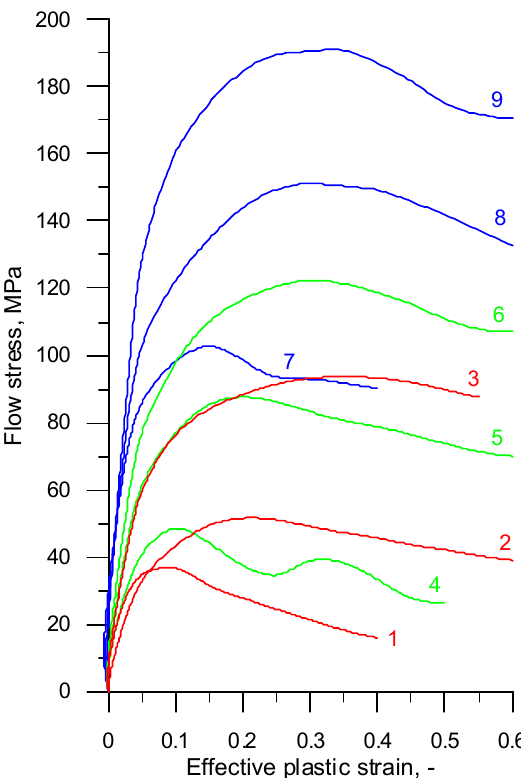
Figure 2. Experimental flow curves for 100Cr6 steel, where 1— T = 1200 °C, ε(cid:4662) = 0.1 s − 1 ; 2— T = 1200 °C, ε(cid:4662) = 1 s − 1 ; 3— T = 1200 °C, ε(cid:4662) = 10 s − 1 ; 4— T = 1100 °C, ε(cid:4662) = 0.1 s − 1 ; 5— T = 1100 °C, ε(cid:4662) = 1 s − 1 ; 6—T = 1100